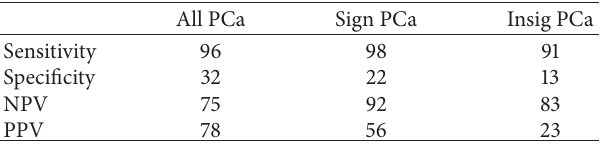
PCa = prostate cancer, Sign = significant, Insig = insignificant, NPV = negative predictive value, and PPV = positive predictive value. insignificant cancer compared to TRUSGB (0.51 versus